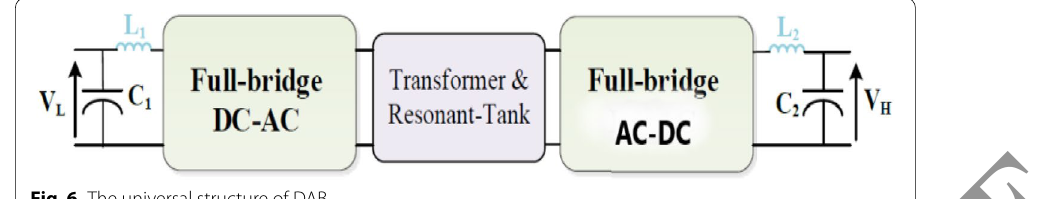
Fig. 6 The universal structure of DAB